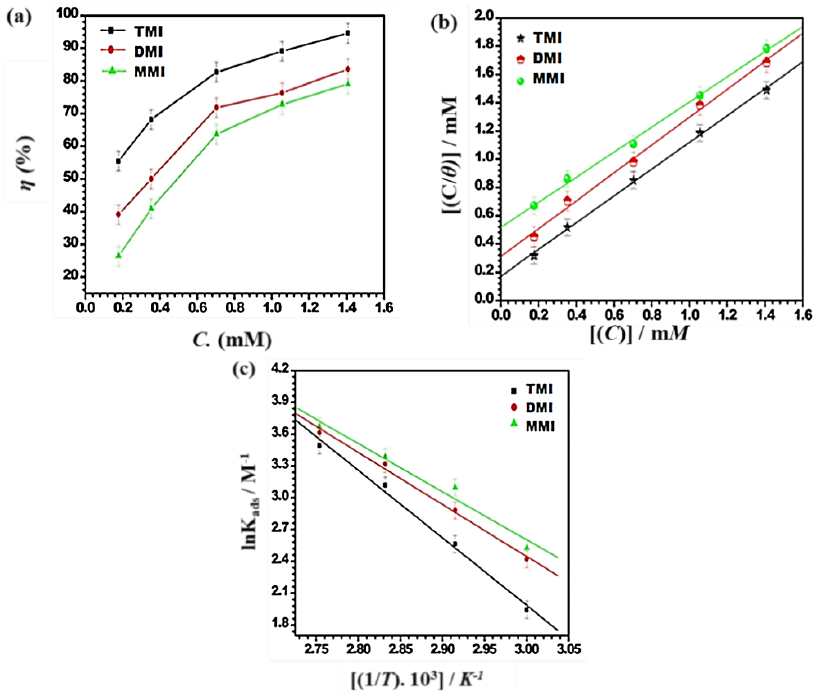
Figure 2. ( a ) Variation of inhibition efficiency ( η %) with inhibitor concentration at 333 K; ( b ) Langmuir Isotherm plots for adsorption of inhibitors; ( c ) The relationship between ln K ads and 1000/ T at optimum concentration of inhibitors. Table 1. Corrosion inhibition efficiency with the inhibitor concentrations. Concentrations